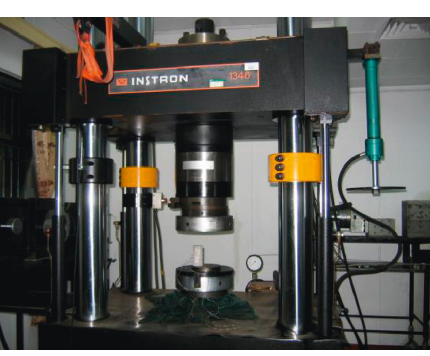
Figure 3: INSTRON-1346 testing